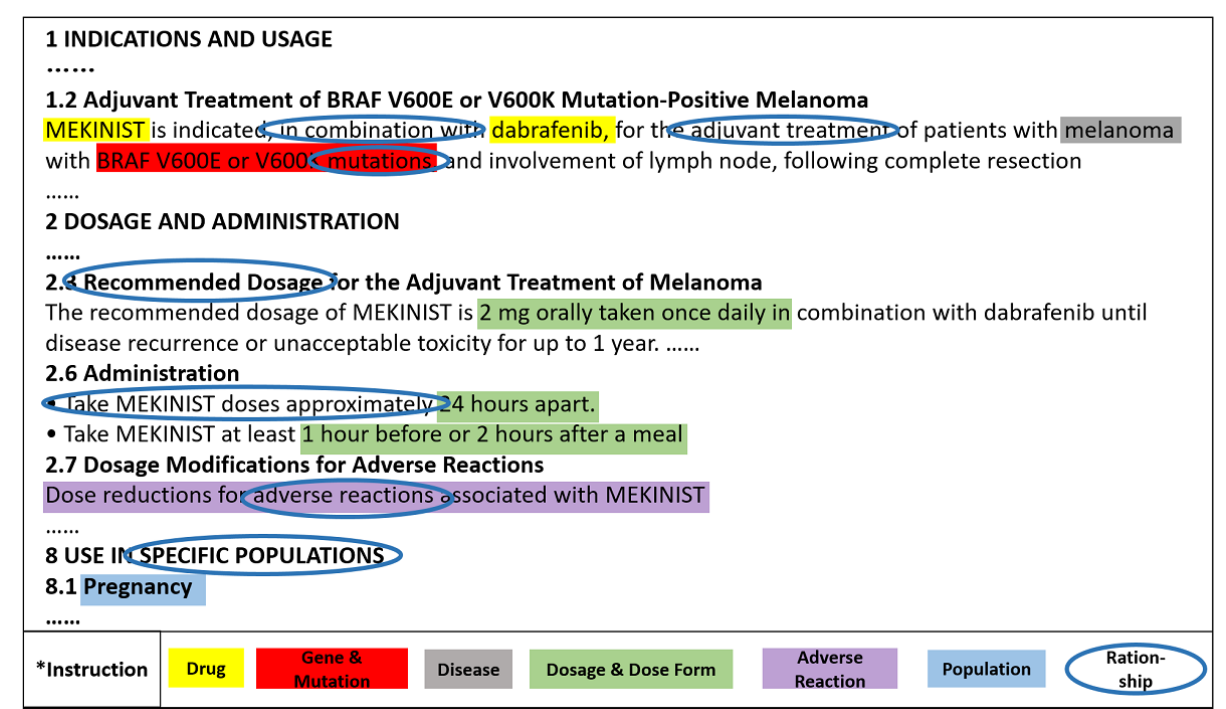
Figure 3. Annotation example of